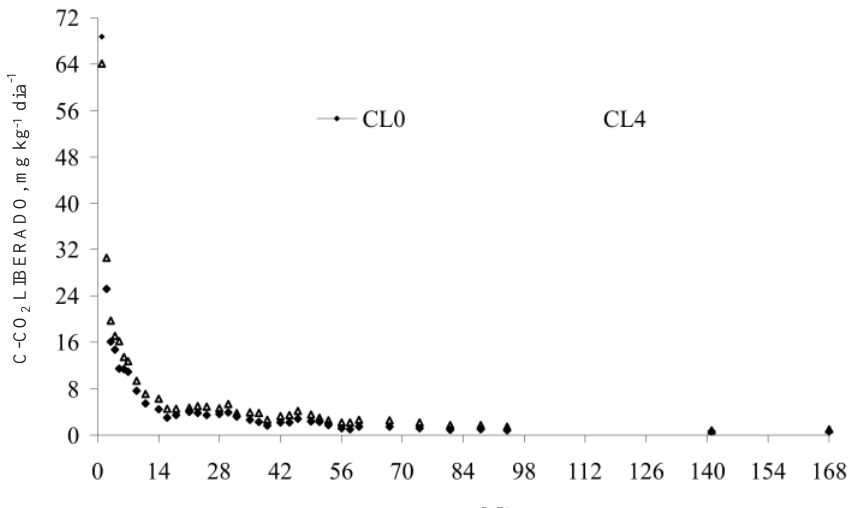
Figura 1. Evolução diária de C-CO (CL ) e no adubado com 120 t ha -1 de composto de lixo urbano (CL 0